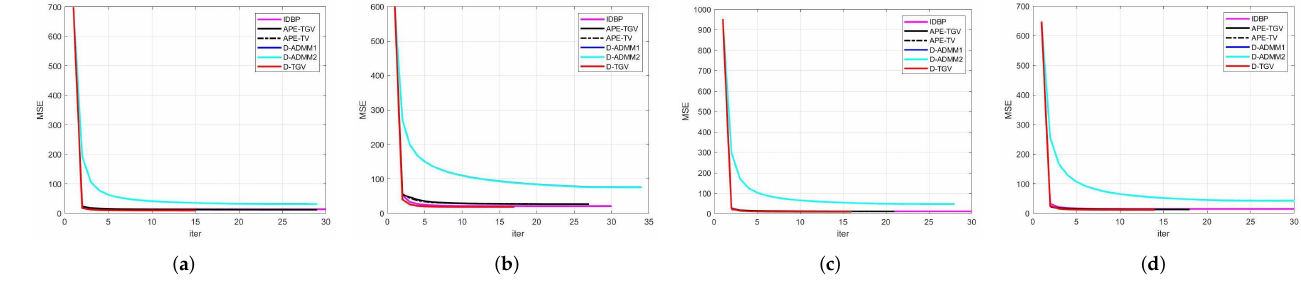
Figure 5. Iteration-varying of MSE. ( a ) Lena, ( b ) Banoon, ( c ) cameraman, and ( d )